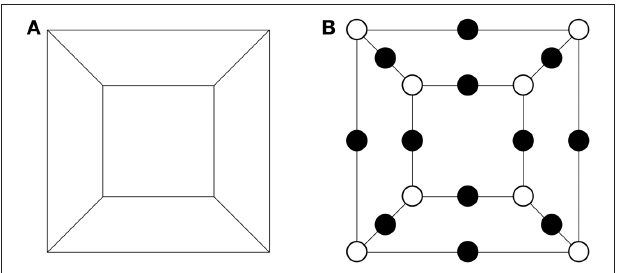
FIGURE 1 | Interpreting the planar graph of the cube as a clean dessin . (A) The planar graph for the cube. (B) The corresponding clean dessin